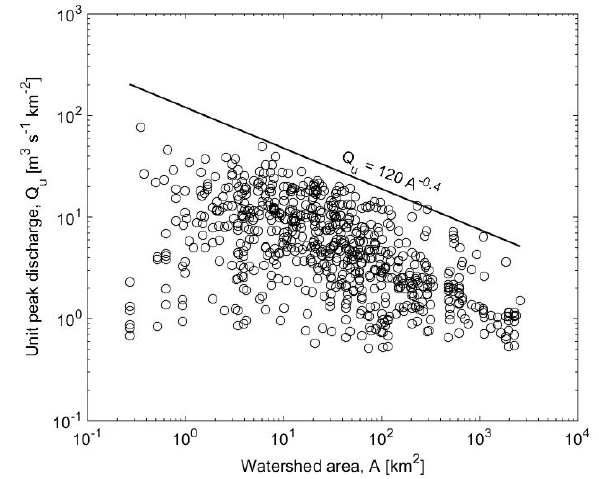
Figure 3. Unit peak discharges versus drainage areas for the studied flash floods. The envelope curve for the upper limit of the relation- ship is